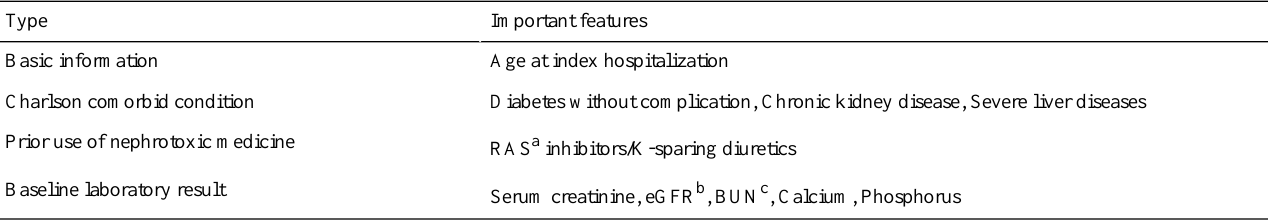
Table 2. Top 10 features selected by the extreme gradient boost (XGBoost) and least absolute shrinkage and selection operator (LASSO) algorithms. Important